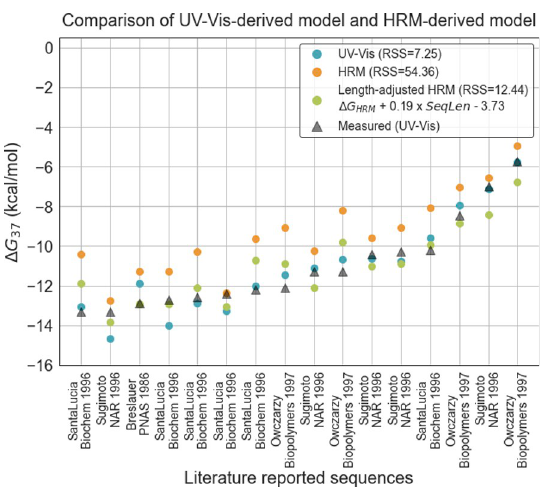
Fig 2. Comparison of Δ G predictions made by the HRM-derived model and reported UV-Vis models for 16 literature reported sequences. Sequences are shown in S6 Table in S1 File . RSS = residual sum of